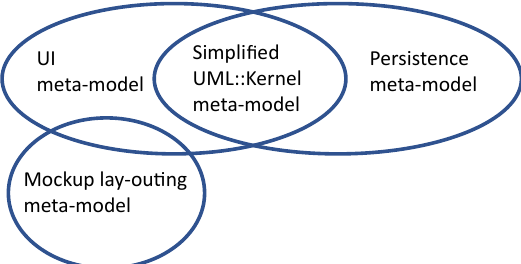
Figure 7. EUIS DSL meta-model structure. Reproduced with permission from [5], Copyright IEEE, 2013.